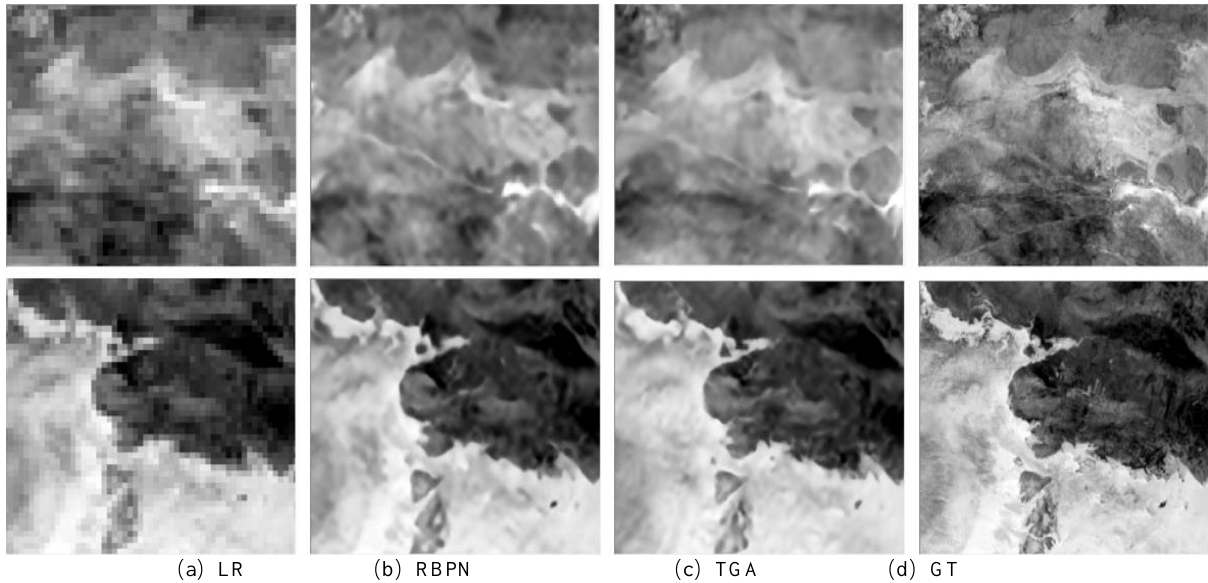
Figure 4 . The top and bottom lines are SR results of subregion A and B in Fig. 3. (a) original LR images, (b) SR results of RBPN, (c) SR results of TGA, (d) Ground